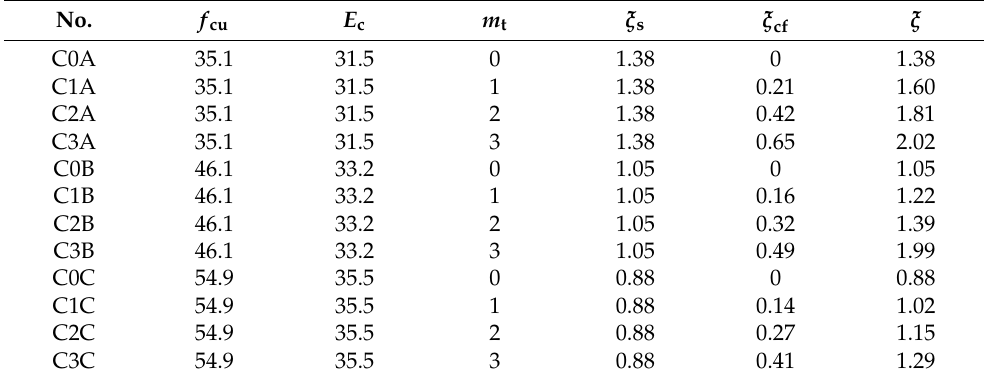
Figure 1. Dimensions of specimens. The outer diameter D s of the steel tube was 120 mm, the wall thickness t s of the steel tube was 2 mm, and the shear span ratio λ = a / D s = 0.075 < 0.2 [1,15]. At this time, the bending moment of the specimen could be ignored, and it was considered that it only bears the shear loading. Other parameters are shown in Table 1. Table 1. Several factors of